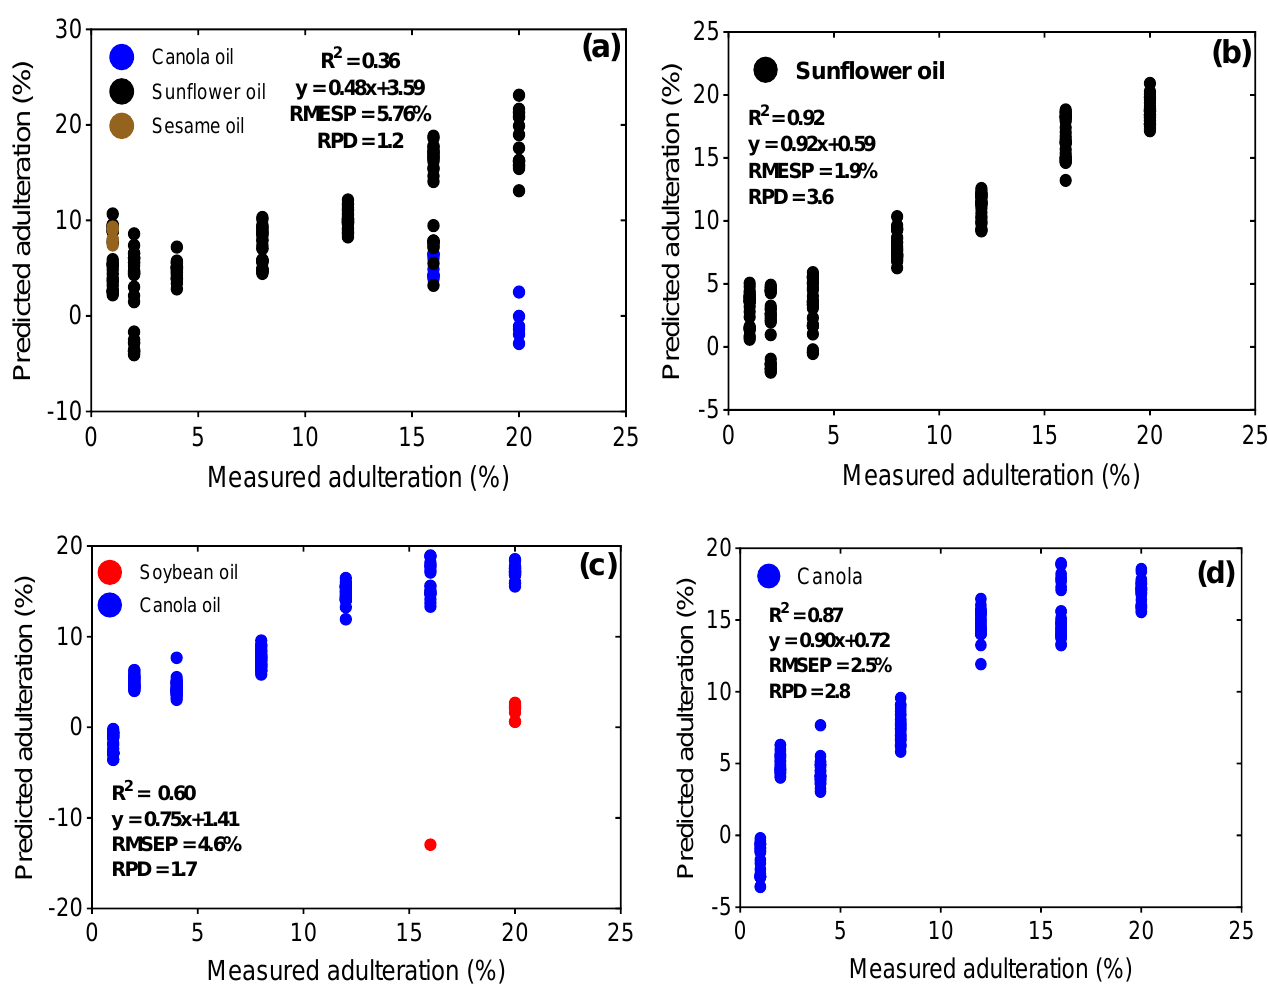
Figure 5. Consequences of PLS-DA misclassifications on the quality of PLS regression models: ( a ) FTIR and PLSR model on EVOO + sunflower test set, considering misclassifications from PLS-DA; ( b ) FTIR and PLSR model on EVOO + sunflower test set based on known identity of the test set; ( c ) FTIR and PLSR model on EVOO + canola test set, considering wrongly classified samples from PLS-DA; ( d ) FTIR and PLSR model on EVOO + canola test set based on the known identity of the test set.